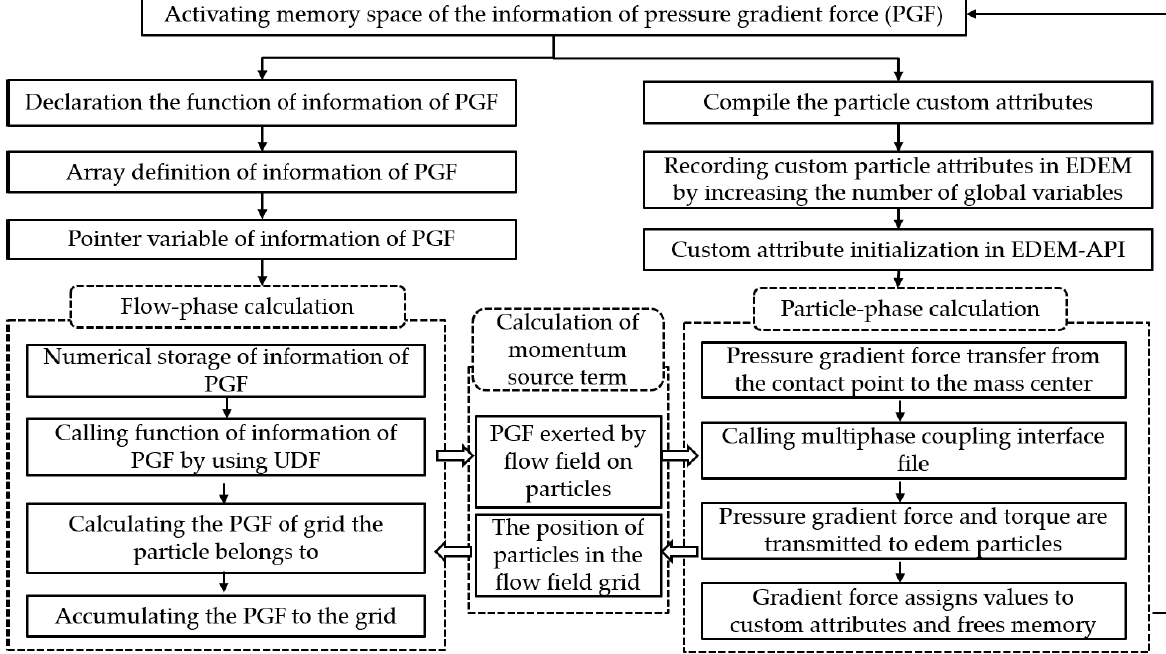
Figure 7. Diagram of compiling and transferring the pressure gradient force (PGF) during the EDEM-CFD simulation.